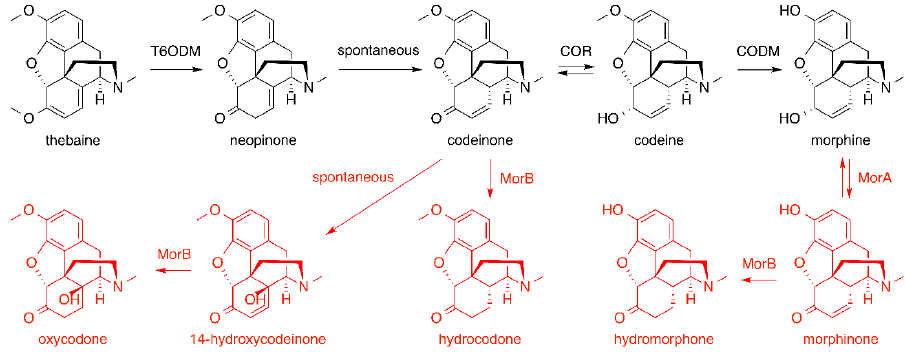
Figure 14. Heterologous biosynthetic pathway constructed in Saccharomyces cerevisiae for the production of morphinan alkaloids and related semi-synthetic opioids from thebaine, the exogenously provided starting material [73]. The biosynthetic pathway leading to the formation of morphine, the prominent member of the morphinan alkaloids, is shown in black. The biosynthetic pathways leading to the formation of semi-synthetic opioids, hydromorphone, hydrocodone and oxycodone, are shown in red. T6ODM, thebaine 6- O -demethylase; COR, codeinone reductase; CODM, codeine O -demethylase; MorA, morphine dehydrogenase; MorB, morphinone reductase.